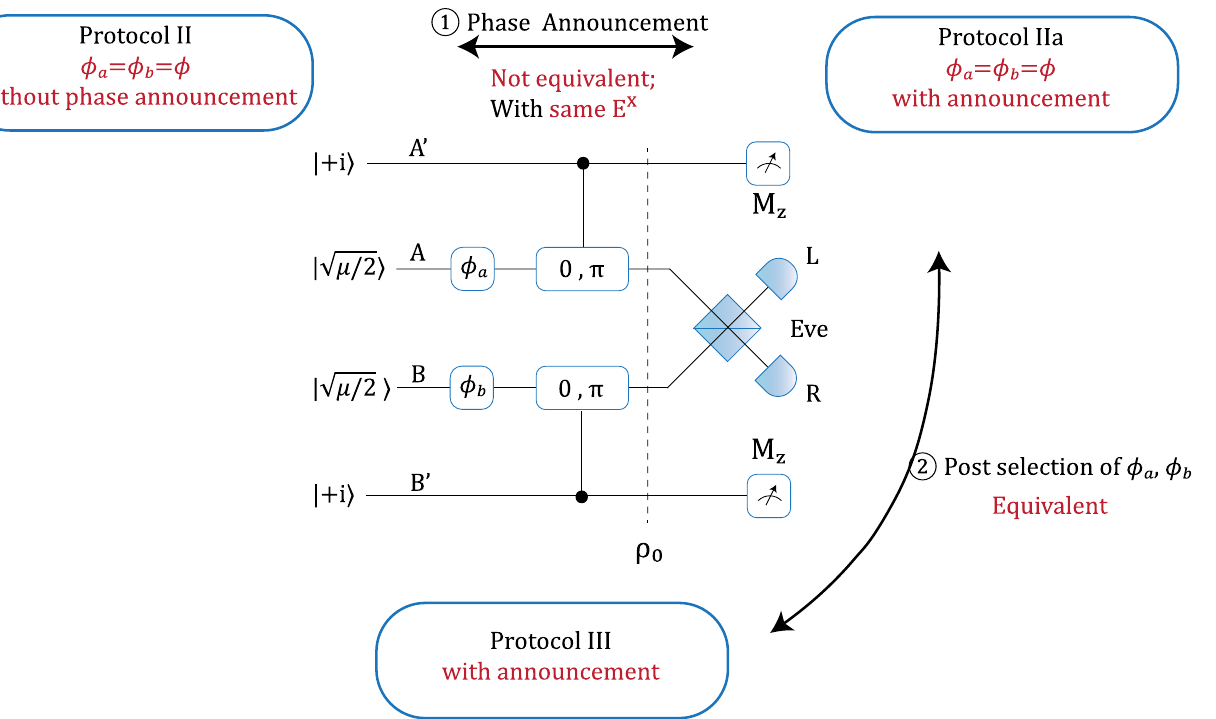
FIG. 6. The schematic diagram of protocols II, IIa, and III. In Protocol II, Alice and Bob add the same phase ϕ ∈ f 0 ; π g on their ffiffiffiffiffiffiffiffi p μ = 2 coherent state . In Protocol IIa, Alice and Bob announce the phase ϕ after Eve ’ s announcement. In Protocol III, Alice and Bob add phases ϕ a and ϕ b , independently. They announce ϕ a and ϕ b after Eve ’ s